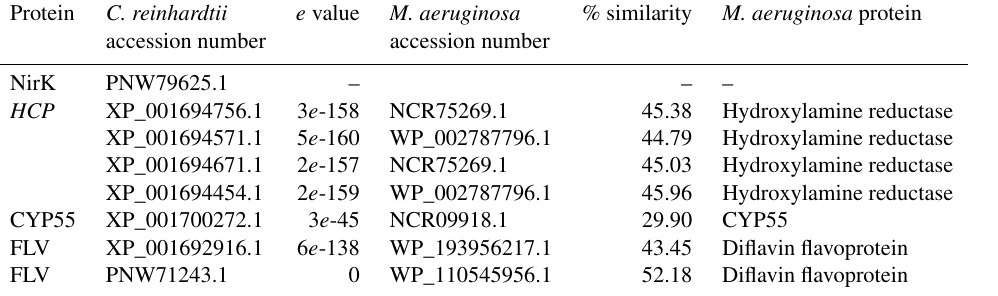
Table 2. Summary of BLASTP results for proteins potentially involved in N 2 O synthesis in Chlamydomonas reinhardtii . Accession numbers were retrieved from Bellido-Pedraza et al. (2020) and used as a query sequence for BLASTP (protein–protein BLAST) protein searches (https://blast.ncbi.nlm.nih.gov/Blast.cgi, last access: 20 September 2022) of the M. aeruginosa (taxid:1126) protein sequences